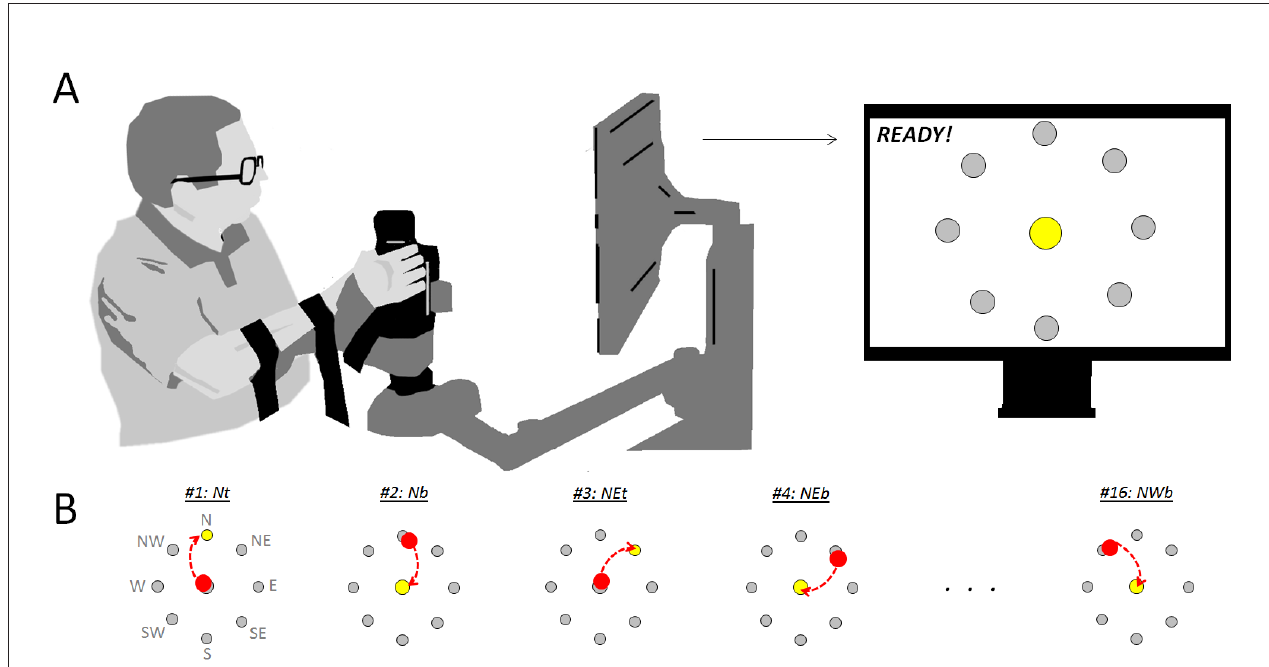
Figure 1 | Visualization participant interacting with robot (a) and demonstration of target task (B) . Red dot shows current cursor location, dashed red line illustrates a trajectory toward the target location (yellow dot). Trajectory is shown in figure for clarity, but was not shown to participants as part of their visual feedback: only the targets and the cursor were